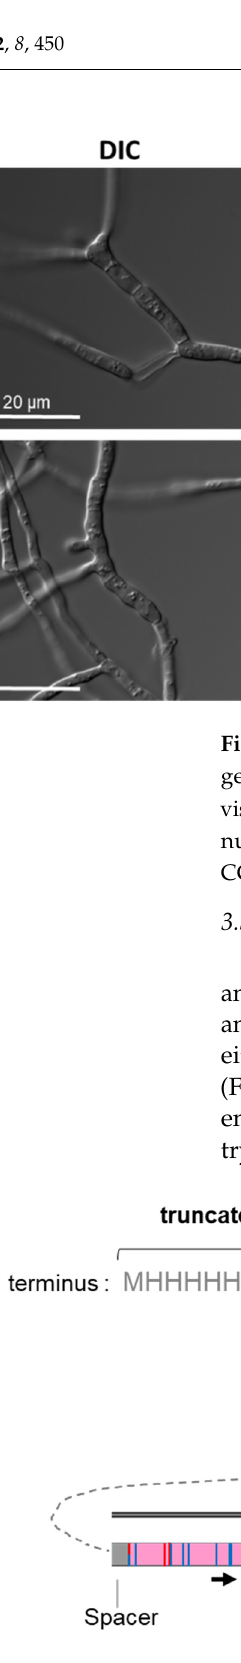
Figure 5. Protein mass spectrometry analysis of trypsin digested total fungal proteins for verifying CCA expression in A. chrysogenum . The total protein extract of fungal mycelia was separated using SDS-PAGE gel, and the gel slices containing proteins of specific size were analyzed by protein MS. Black arrows indicate the identified peptides. Amino acids at the truncated N-terminal region of the α -subunit are given. The catalytic amino acids are indicated as red bars, and the amino acids, which have contact with the CCA substrate, are marked by blue bars.